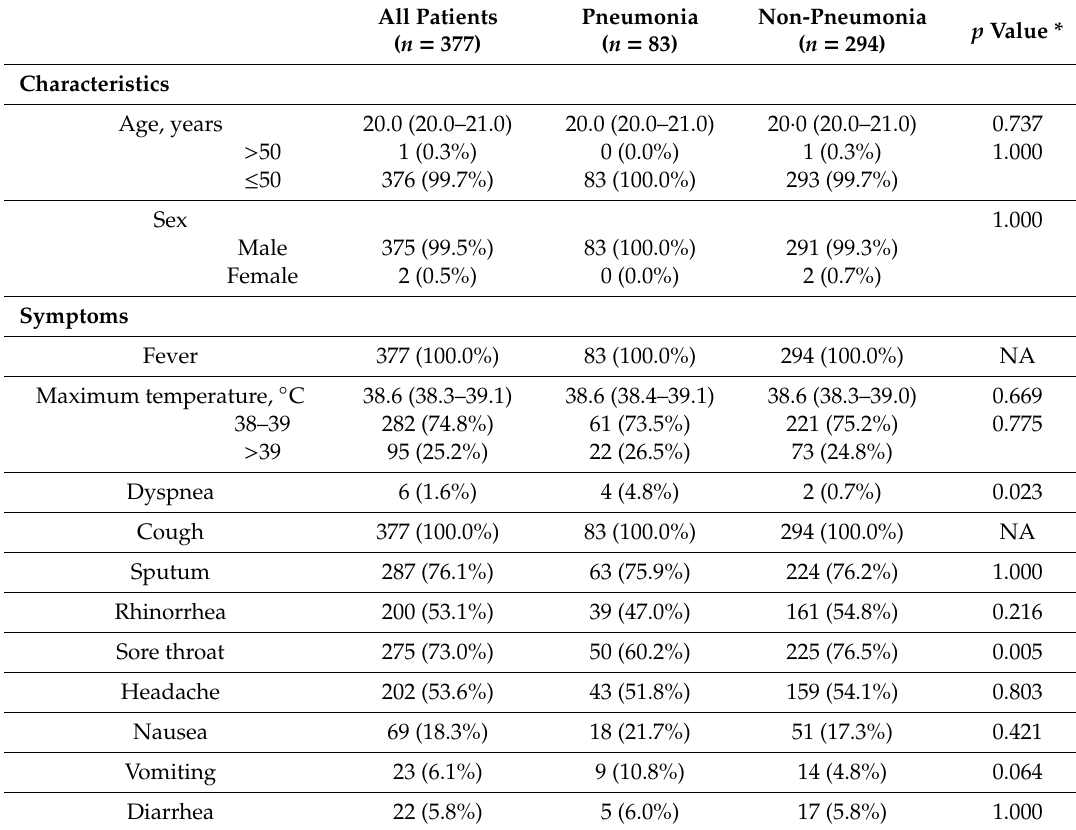
Table 1. Clinical Characteristics of Patients with Acute Febrile Respiratory